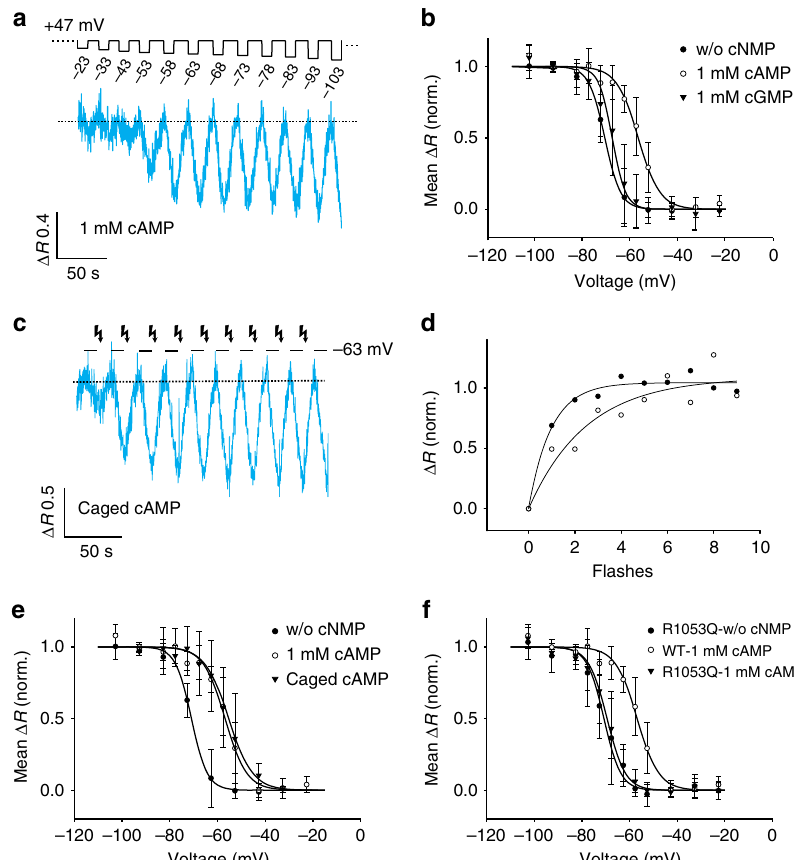
Fig. 4 Modulation of Sp SLC9C1 activity by cAMP. a Action of 1 mM cAMP in the pipette solution on the voltage dependence of Sp SLC9C1 ( V 1/2 = − 53.4 mV). ([Na + ] o 0 mM; [Na + ] i 14 mM; pH i = 7.2; pH o = 7.4). b Normalized Δ R values were plotted against V m to yield the V 1/2 values by a fi t with the Boltzmann equation (w/o cNMP: V 1/2 = − 70.9 ± 2.5 mV, s = 3.3 ± 0.9 mV, n = 7; cAMP: V 1/2 = − 56.8 ± 2.7 mV, s = 4.6 ± 1.5 mV, n = 7; cGMP: V 1/2 =